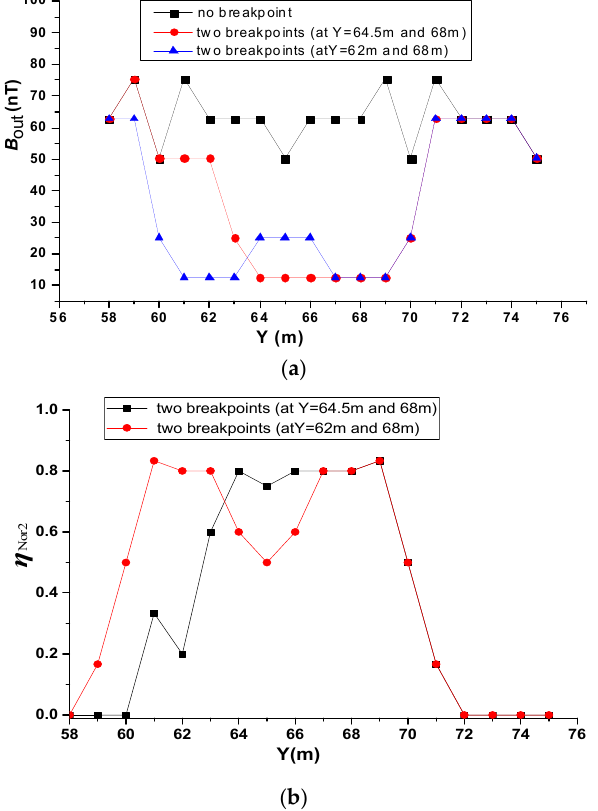
Figure 11. Simulations of two breakpoints at different intervals. ( a ) Secondary field along the survey line above the #6 conductor. ( b ) Secondary field changes normalized to the case without two